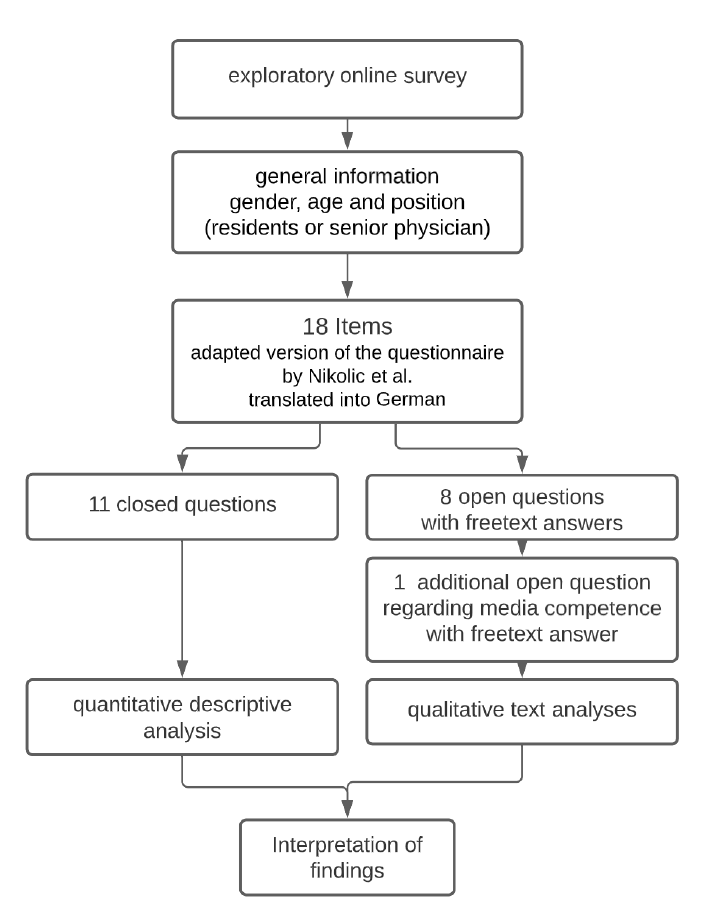
Figure 1. Flowchart of methodology (adapted version of the questionnaire by Nikolic et al. [18])